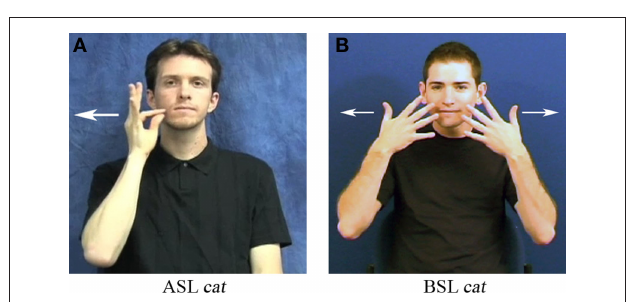
FigurE 3 | The signs meaning cat in aSL (a) and BSL